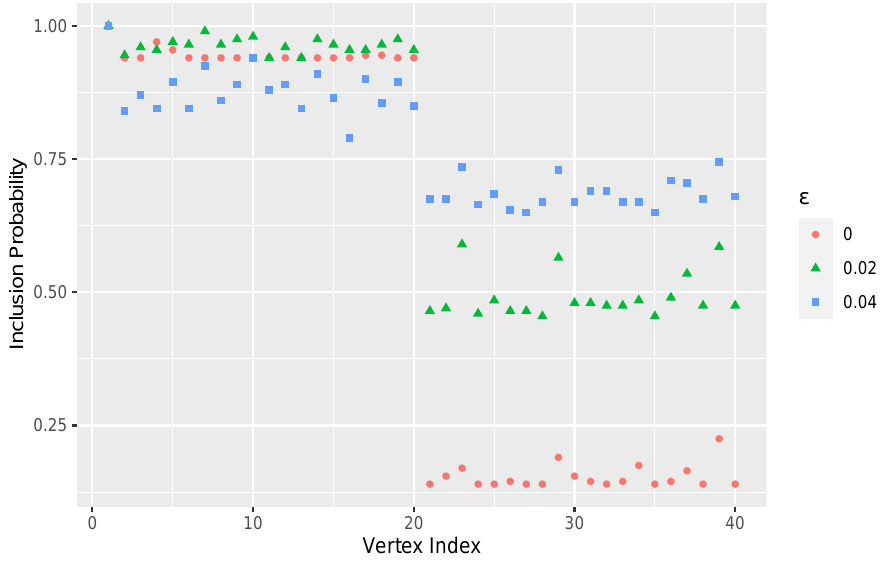
Figure 4. Plot of inclusion probabilities of vertex 1 in the simulated network in Figure 3. Three tolerance parameters ( (cid:101) = 0,0.02, and 0.04) are used. As (cid:101) increases, more of the network is